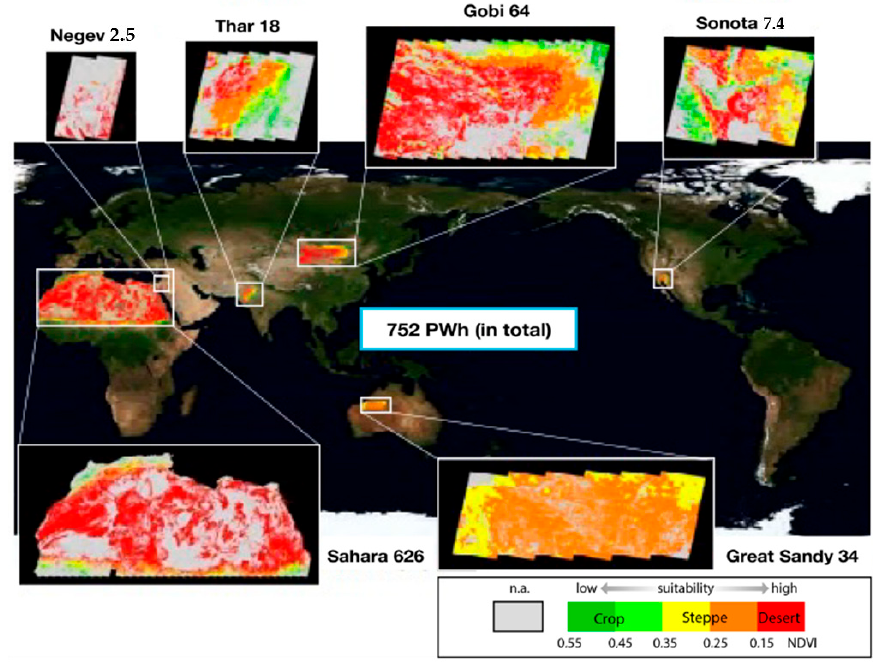
Figure 3. Some potential installations of PV power plants in deserts around the world.